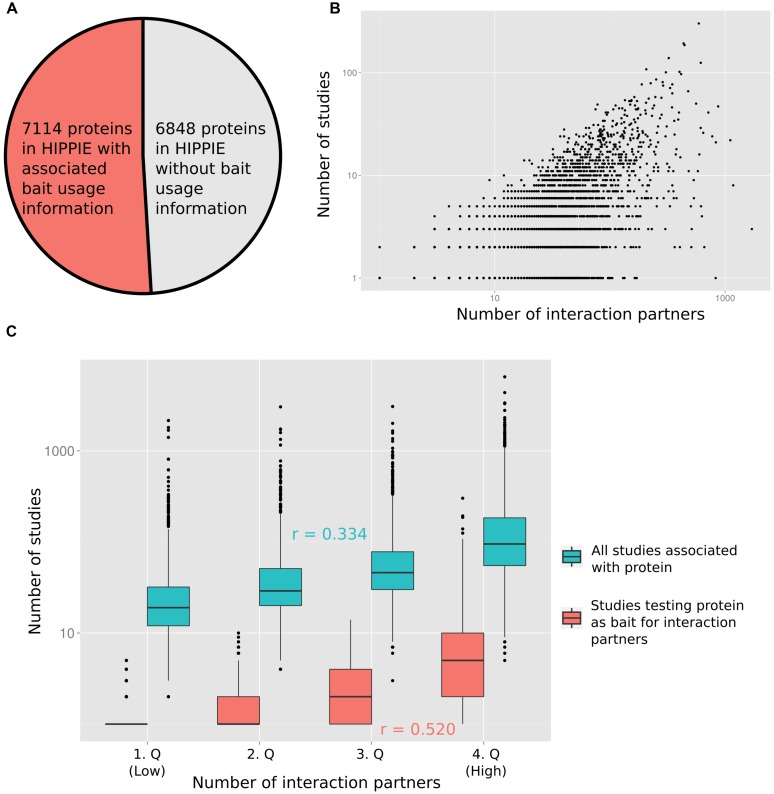
(A) For slightly more than half of the proteins in HIPPIE we had information of how often they had been tested as bait proteins for interaction partners. (B) The number of studies in which a protein has been tested as a bait for interaction partners is positively correlated with the number of reported interactions (Pearson correlation of 0.520). (C) The protein–protein interaction (PPI) degree distribution has been split into four equally sized quartiles (1.Q–4.Q). The distribution of numbers of all studies and only those studies testing the associated proteins as baits for interaction partners are shown for the quartiles. Pearson correlation values (r) are indicated.